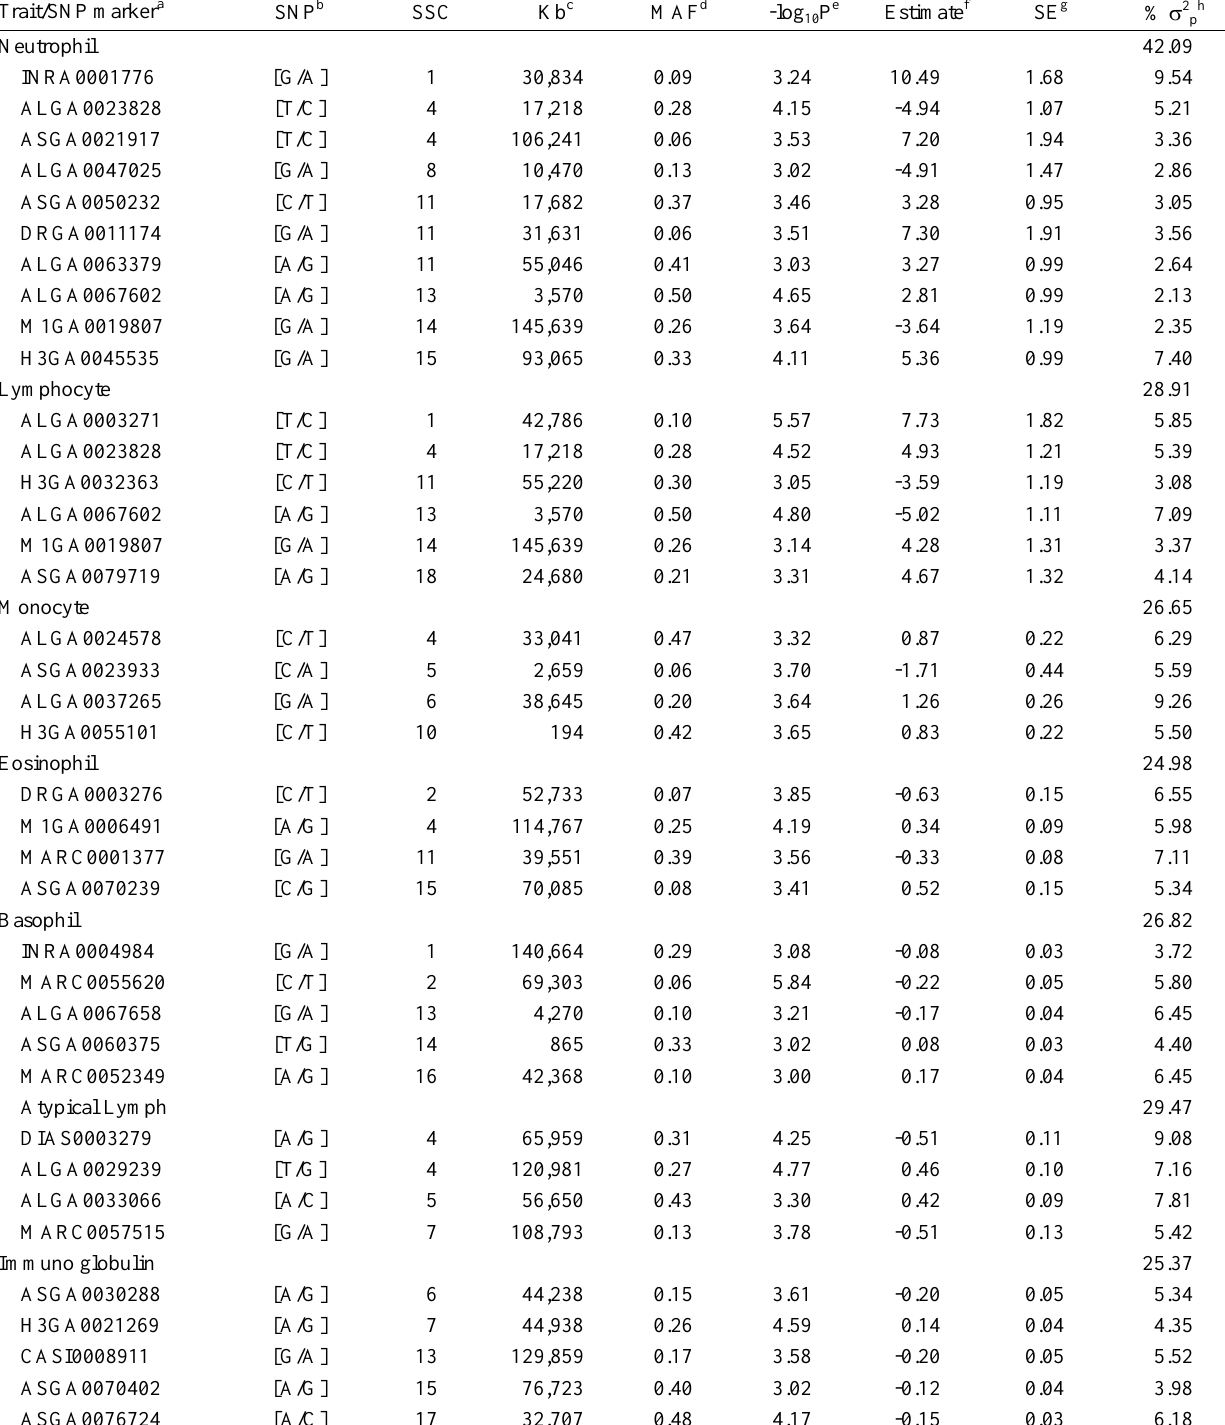
Table 3. Identities, positions, and effects of the SNPs associated with blood component traits in a KNP  YK cross population Trait/SNP marker